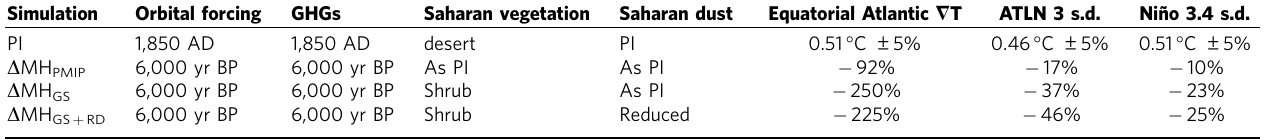
Boundary conditions for each modelling experiment, the equatorial Atlantic temperature gradient in JASO (3 (cid:2) S–3 (cid:2) N 40 (cid:2) W–30 (cid:2) W; 10 (cid:2) –3 (cid:2) S 0–8 (cid:2) E), the standard deviations of the Atlantic Nin˜o 3 (3 (cid:2) S–3 (cid:2) N 15 (cid:2) –0 (cid:2) W) and Nin˜o 3.4 (5 (cid:2) S–5 (cid:2) N 120 (cid:2) –170 (cid:2) W) indexes for the preindustrial (PI) with approximate 95% confidence intervals (twice the s.e.m., see Methods section for details) and the relative changes in the MH